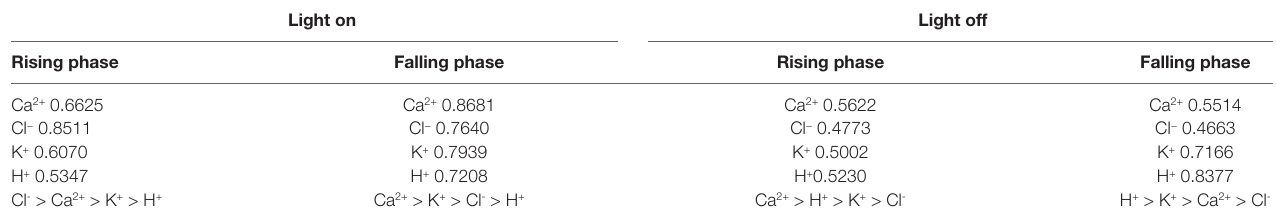
TaBLe 2 | Gray relational grades between each ion flux and surface potential under illumination and darkness. Light